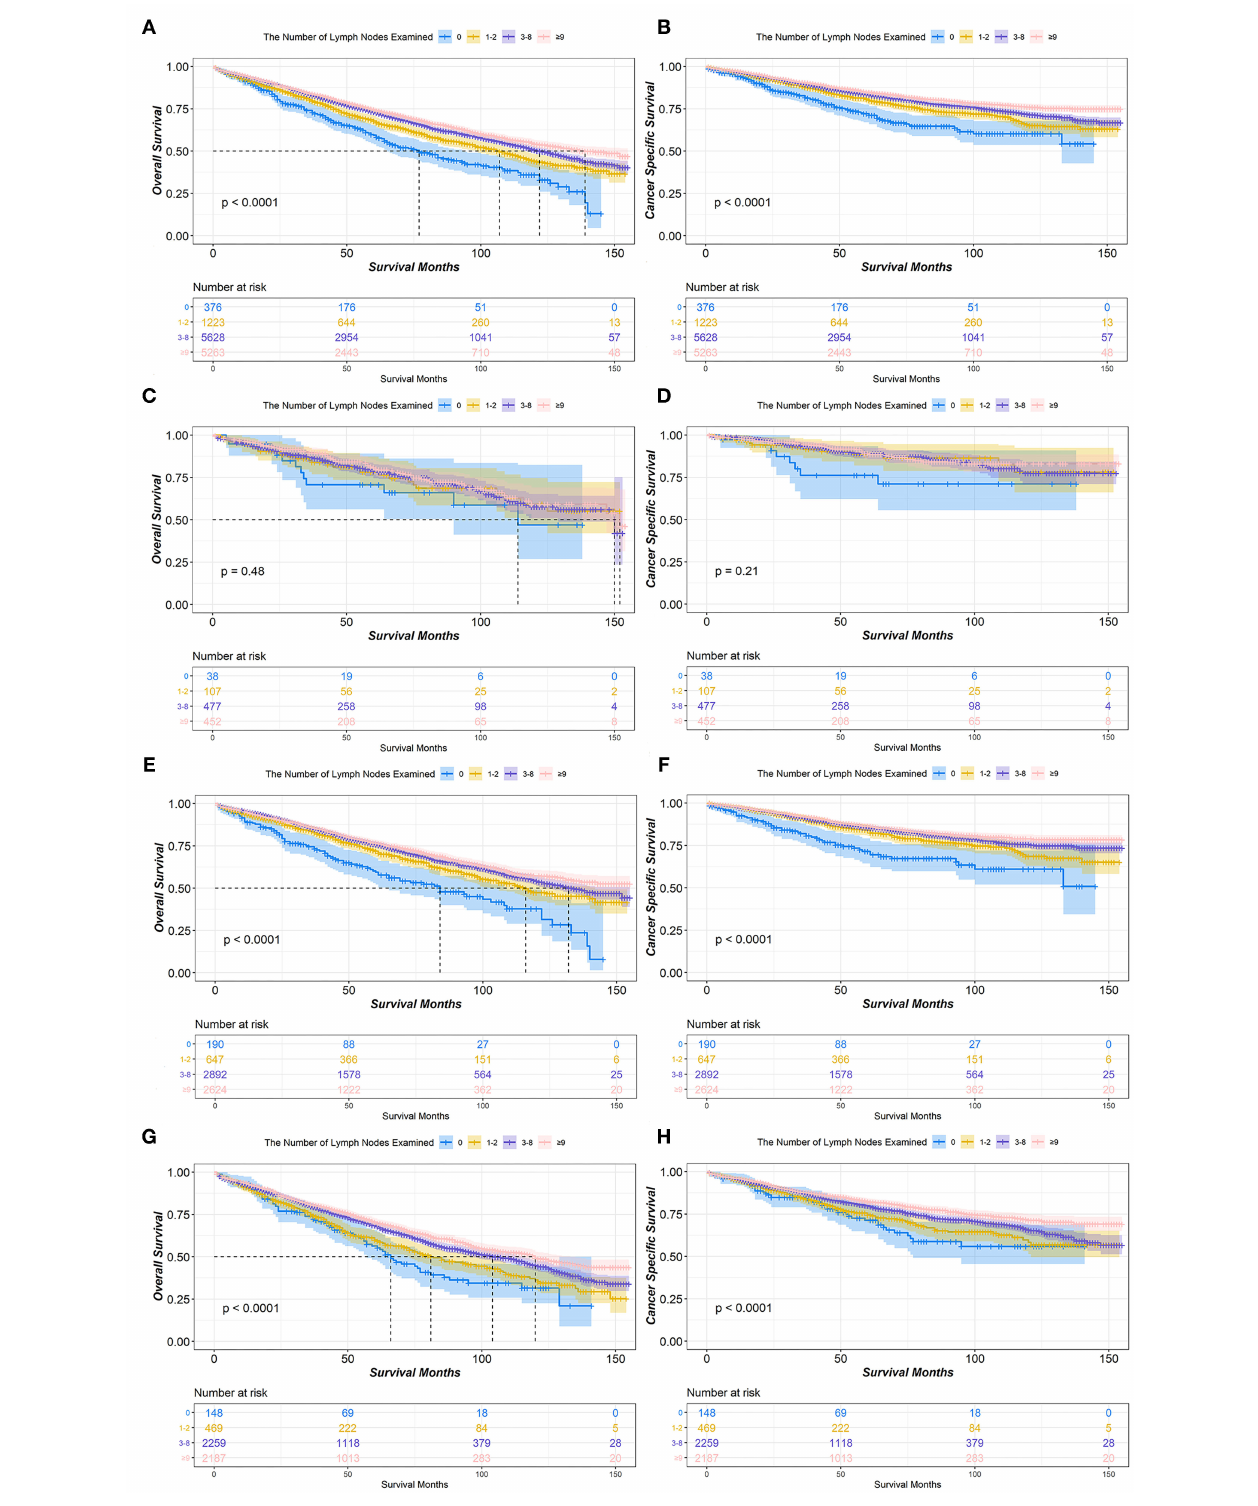
FIGURE 1 | Kaplan-Meier survival curves of the number of lymph nodes examined in IA non-small cell lung cancer (NSCLC) patients who underwent lobectomy or bilobectomy. Overall survival comparison among 0, 1–2, 3–8, and ≥ 9 lymph nodes examined in stage IA (A) NSCLC patients including T1a (C) , T1b (E) , and T1c (G) . Cancer-specific survival comparison among 0, 1–2, 3–8, and ≥ 9 lymph nodes examined in stage IA (B) NSCLC patients including T1a (D) , T1b (F) , and T1c (H) .